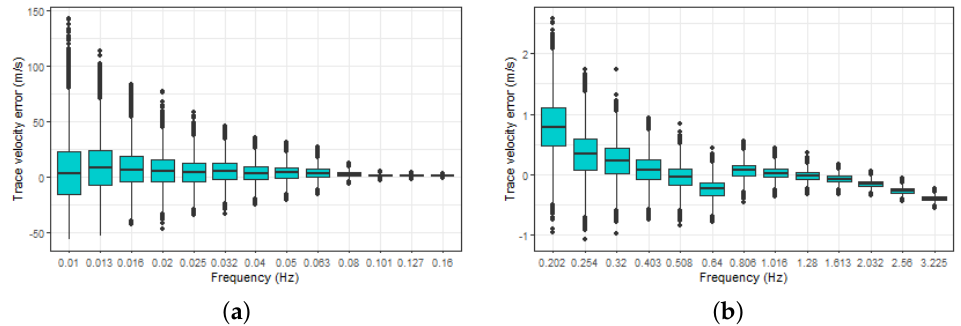
Figure 11. The same as Figure 10, for the trace velocity error (bias). ( a ) Frequency lower than 0.2 Hz. ( b ) Frequency higher than 0.2 Hz.